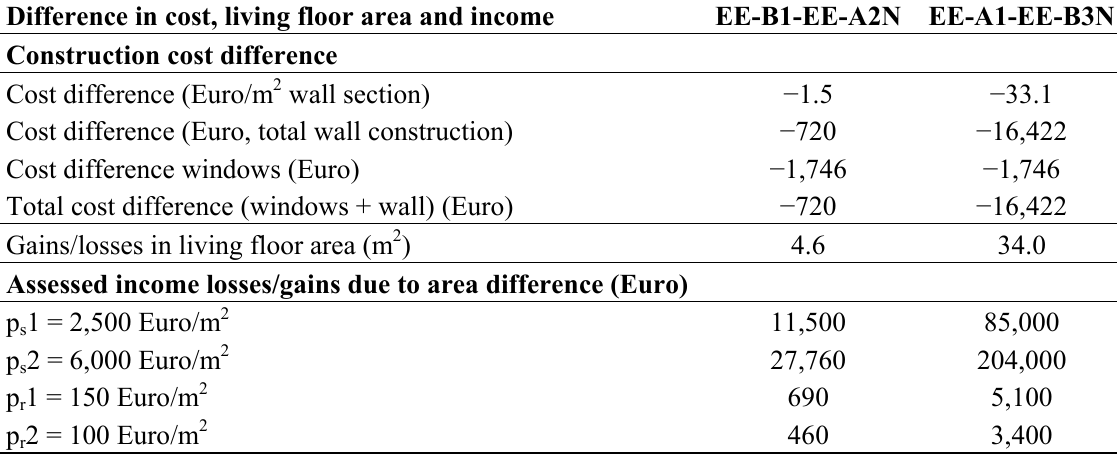
Table 13. Cost difference and assessed living area lost between energy-efficient and energy-efficient building constructed with new product, brick